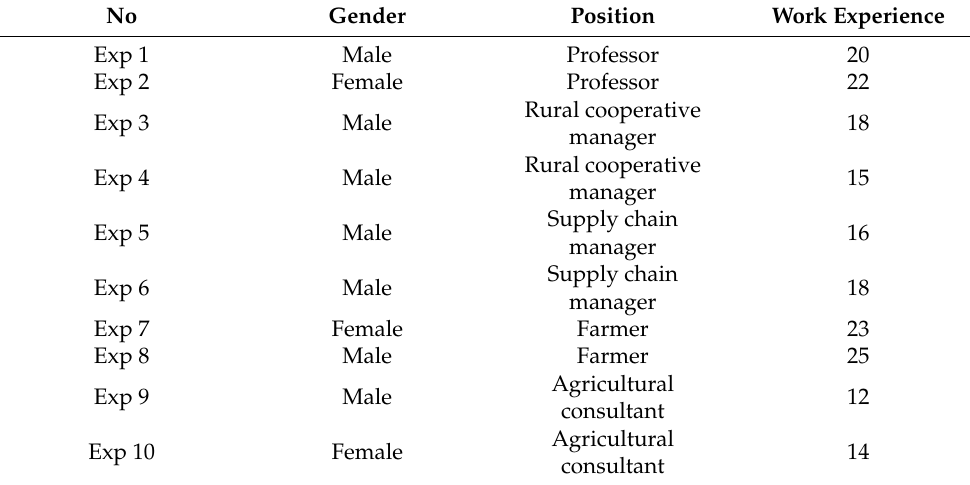
Table 5. Information of the